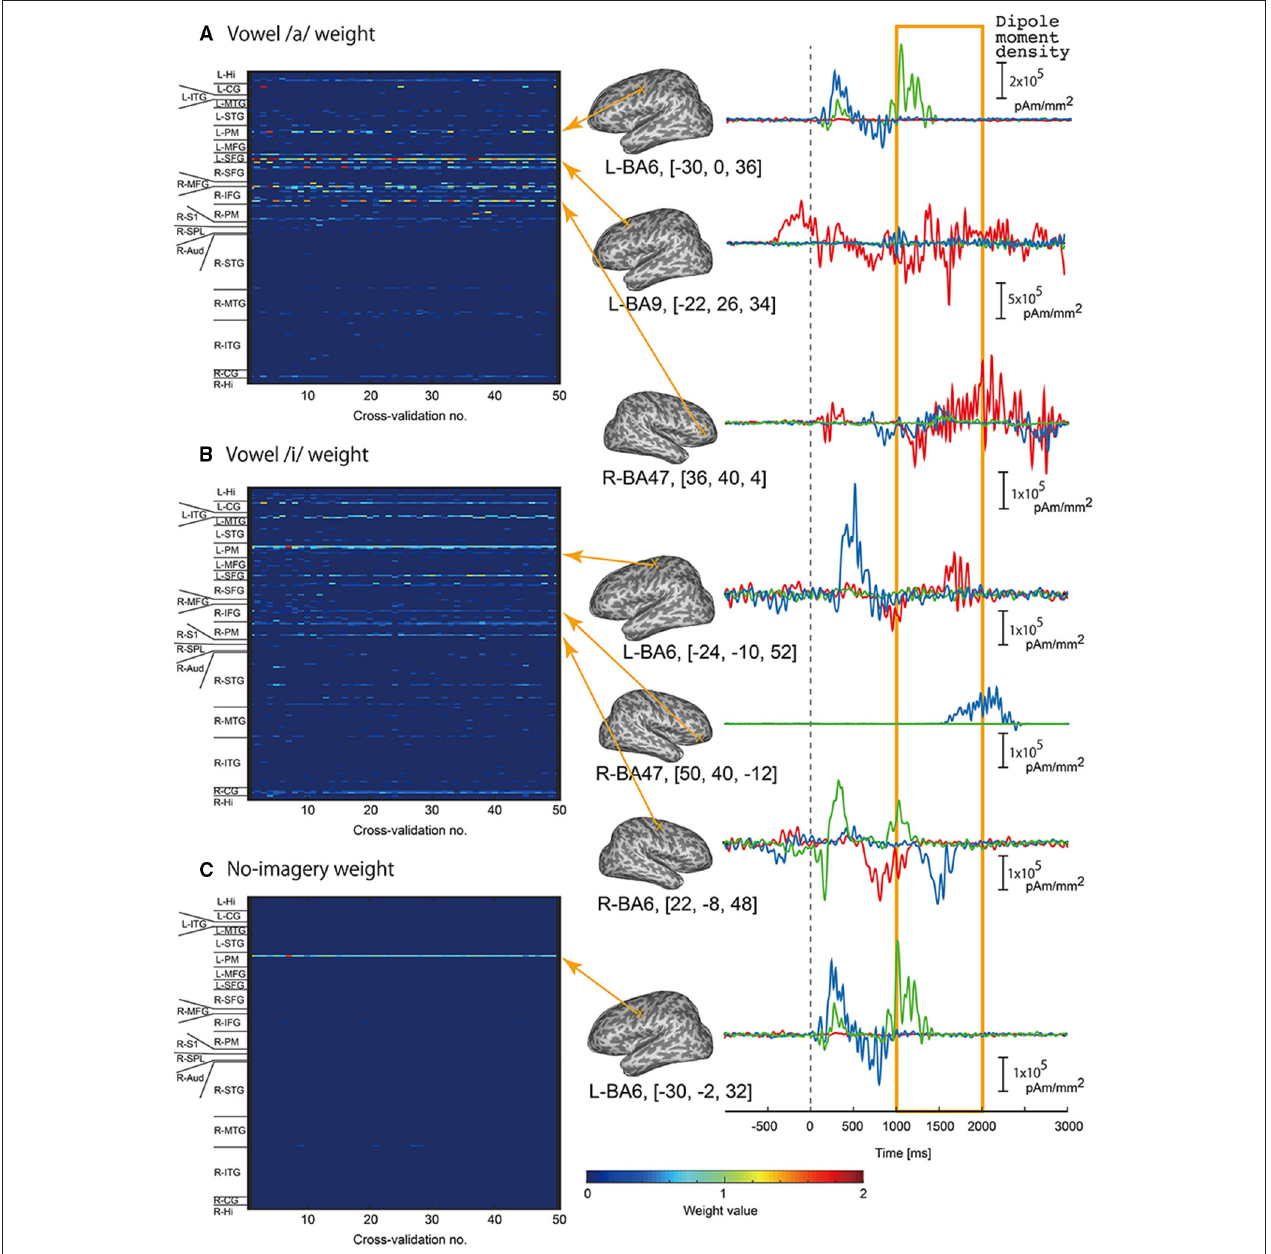
FIGURE 6 | Examples of EEG cortical current signals in the same participant in Figure 5. Left panel: Color maps of mean weight values of all vertices sorted according to brain areas for each cross-validation analysis calculated by classifier for vowel /a/ (A) , vowel /i/ (B) , and no-imagery (C) . Right panel: Frequently selected vertices with high mean weight values (FSHV-vertices) were selected from the color maps, and mean time series signals across trials were plotted. Red lines represent signals during vowel /a/ task, blue lines represent vowel /i/ task, and green line represent no-imagery task. Signals from 1 to 2s after the auditory stimuli (orange box) were used for classification analyses. Positions of the FSHV-vertices and their MNI standard coordinates are shown beside each signal plot. MNI standard coordinates of the current vertices were calculated using the normalization matrix obtained from SPM analysis to determine anatomical locations of the current vertices.